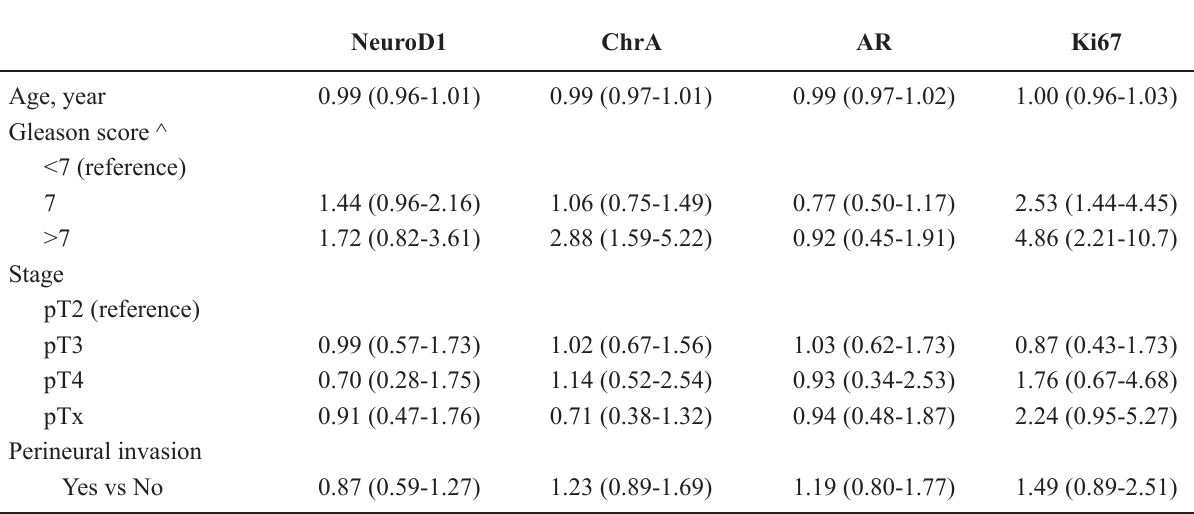
Tables entries are OR and 95% confidence intervals. ^ p for trend test is <0.05 NeuroD1, ChrA and Ki67. ChrA=chromogranin-A; AR=androgen receptor; Ki67=Ki67 label